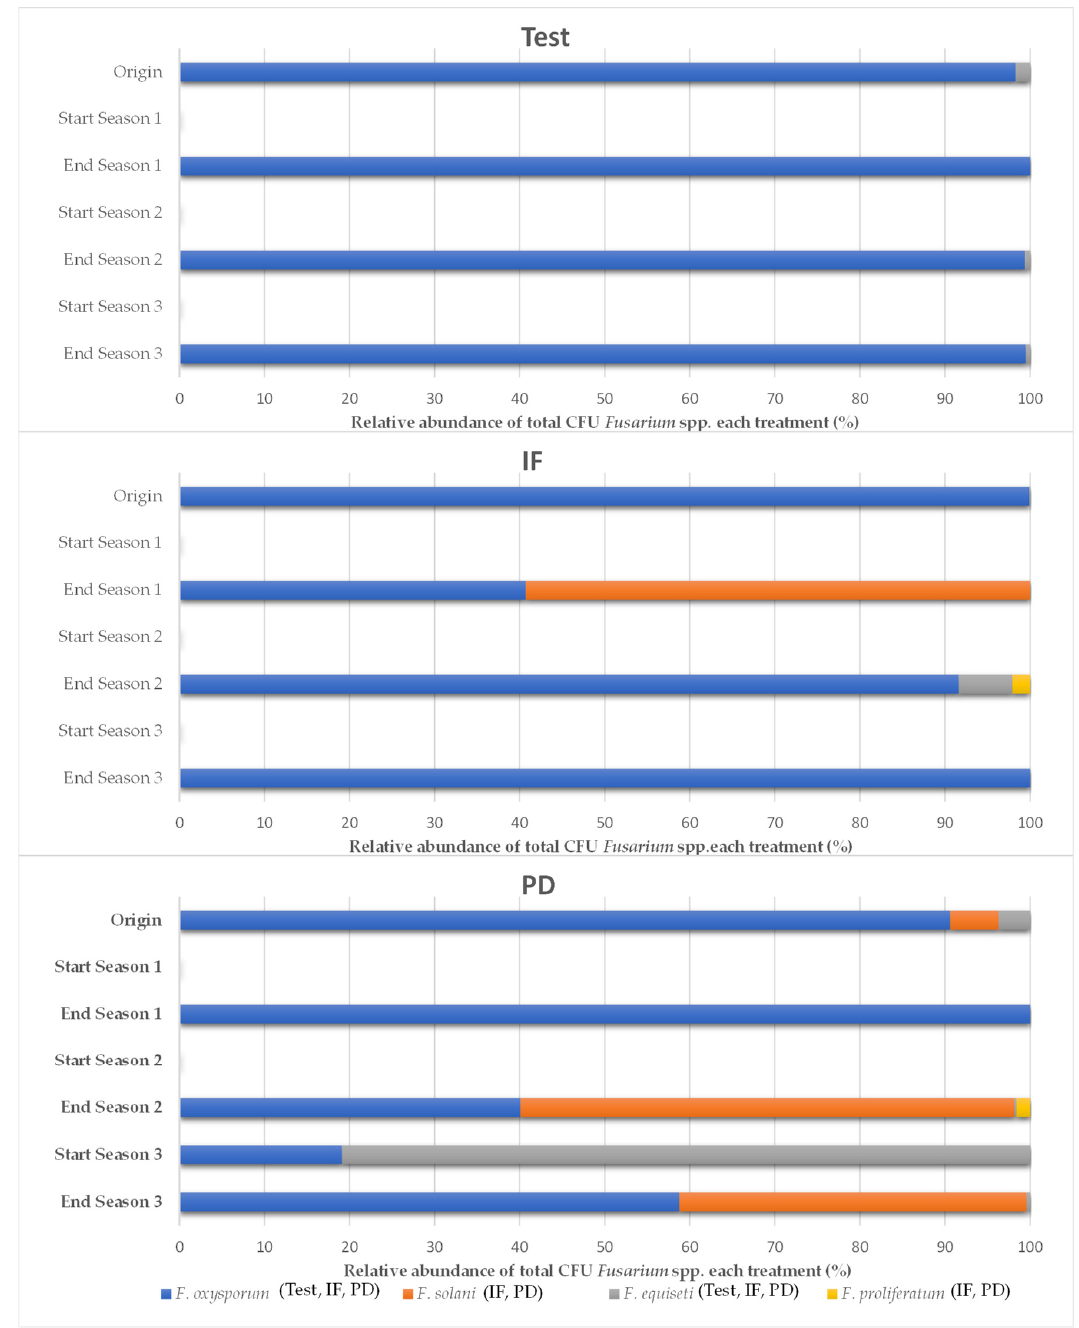
Figure 5. Relative abundance of Fusarium species in the three years of study (September–April cycles) as a function of crop nutrition. Inorganic fertilization (IF; n = 4); tomato plant debris (PD; n = 4); no fertilization (test; n = 4). Values (average).